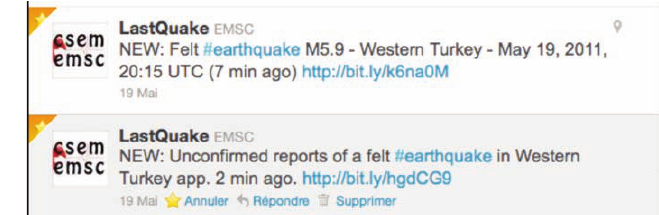
Figure 6. Change over time in the number of sessions (blue) and the number of session closures observed on the EMSC website for a 30 s window on March 14, 2010. The sudden increase in the number of closures (black and red) at 23:43 UTC was due to a massive power failure which affected Chile. At the time of the blackout, the number of sessions originating from Santiago (blue) dropped by 31% which is similar to the estimation of 27% of the affected population in the city.